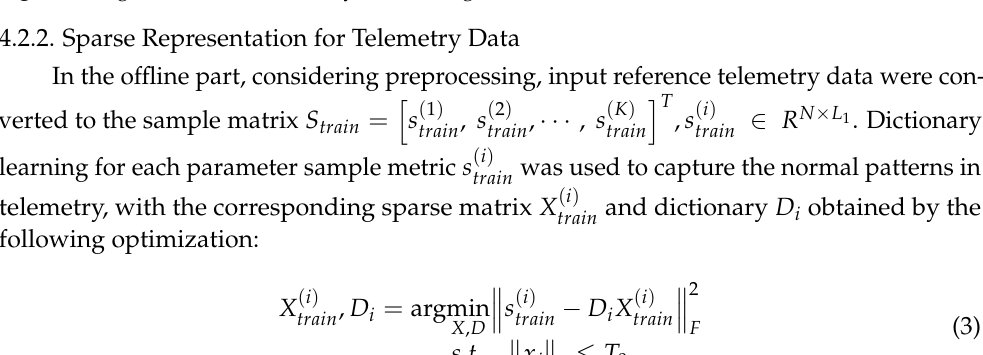
Figure 4. Segmentation of telemetry into sliding windows.